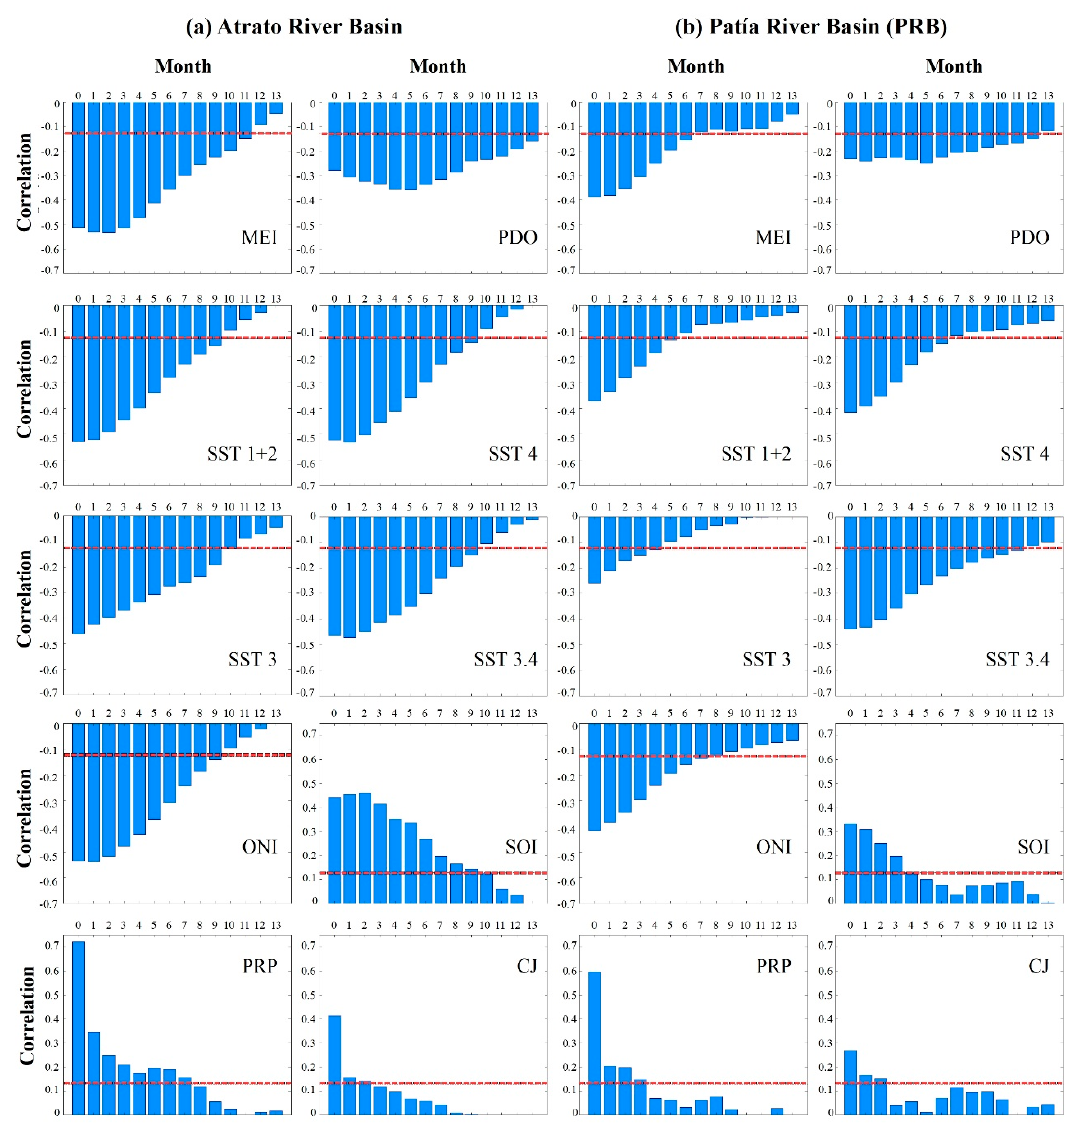
Figure 5. Cross-correlograms between climatic indices and PC1s of discharges. ( a ) ARB and ( b ) PRB. The dashed lines indicate a significance level of 0.05.